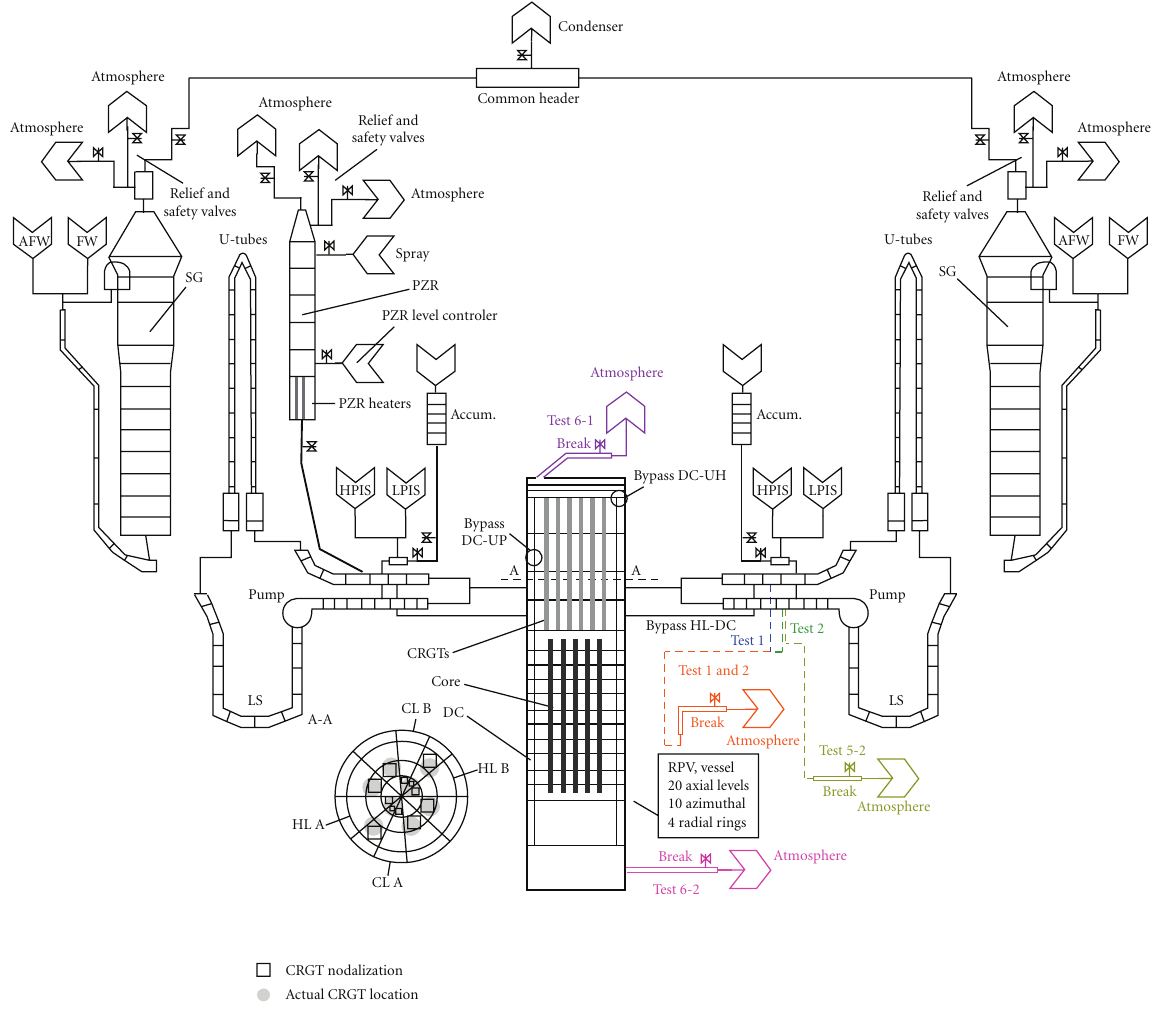
Figure 1: TRACE nodalization of the ROSA/LSTF.